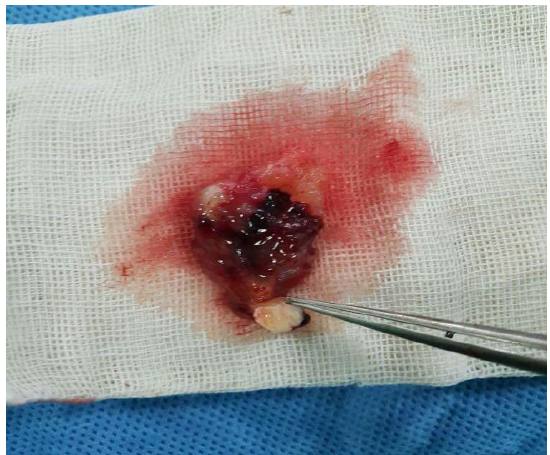
Figure 2 .Atrial myxoma (Myxoma with a size of 10×5 mm was removed from the pedicle)